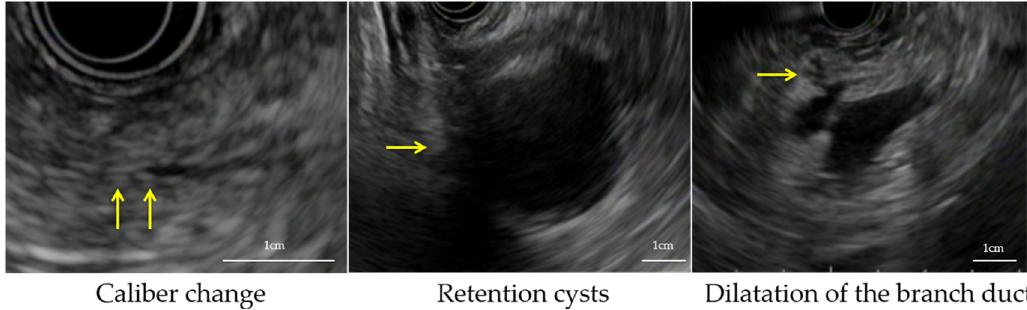
Figure 1. The definition of indirect findings: caliber change, retention cysts, and dilatation of the branch